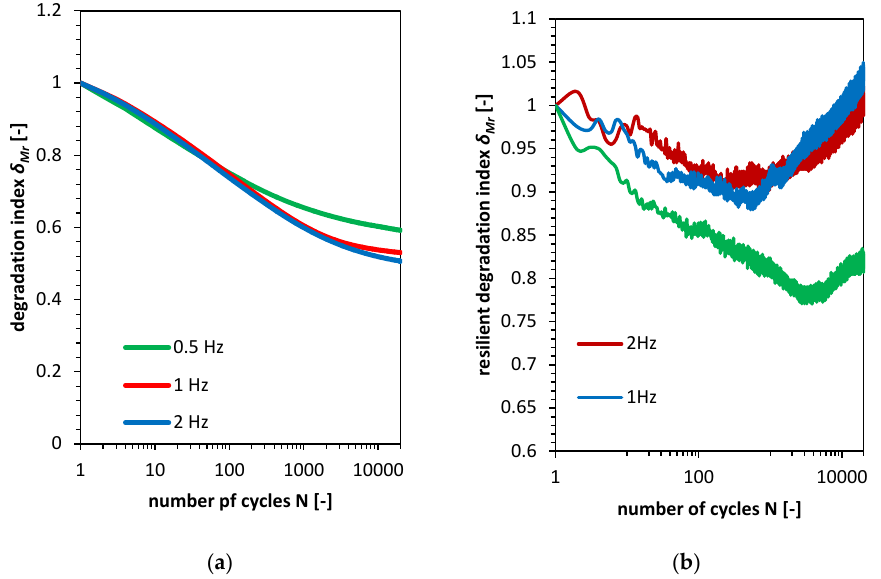
Figure 7. Modulus change characteristics as the degradation index versus number of cycles: ( a ) degradation index; ( b ) resilient degradation index.